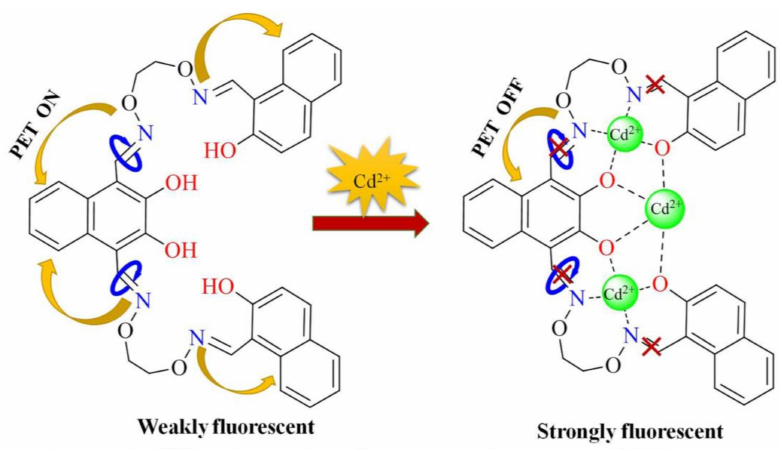
Figure 8. The sensing mechanism of the sensor H 4 L for Cd 2+ .